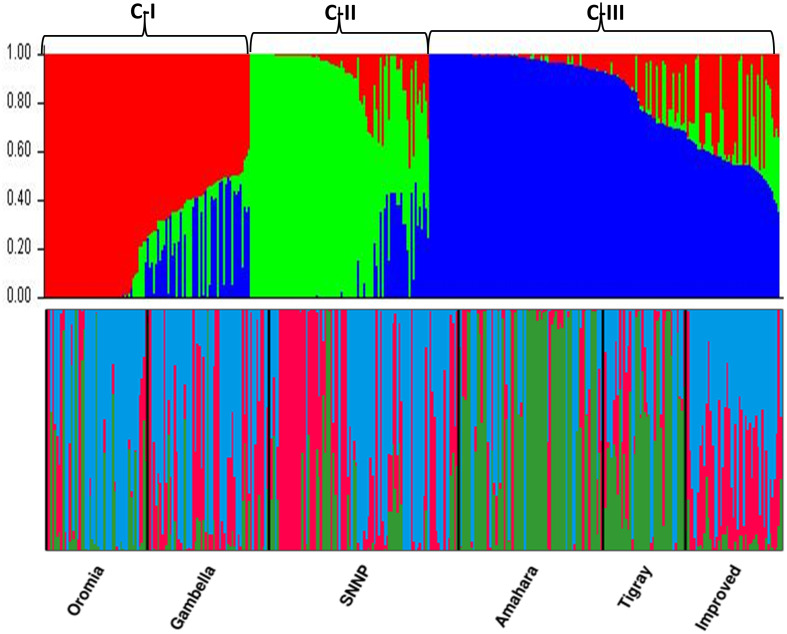
Population structure of 357 cowpea genotypes, in K = 3; each color represents one cluster.